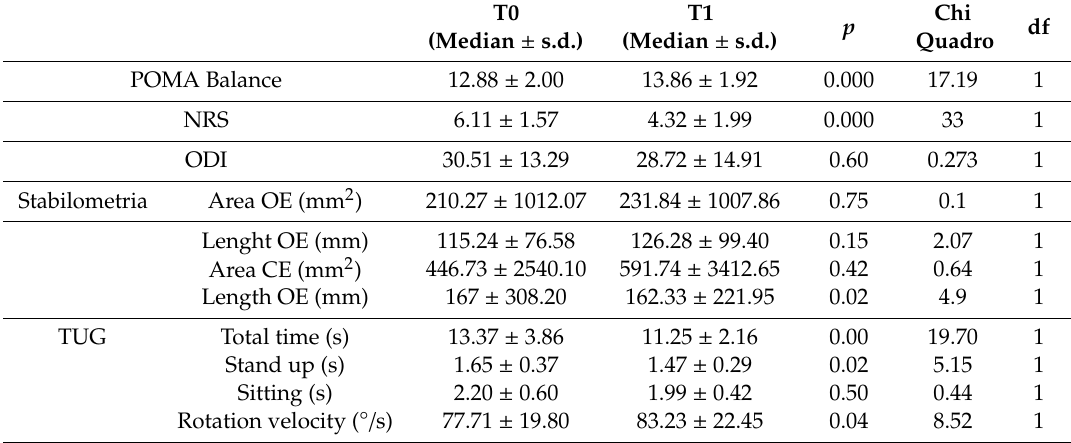
Table 1. Clinical scale and instrumental evaluation before and after back school